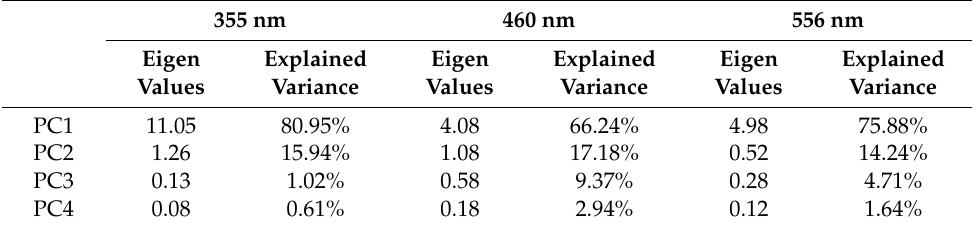
Table 1. Percentages of explained variance for the first four principal components (PCs) with different excitation wavelengths.